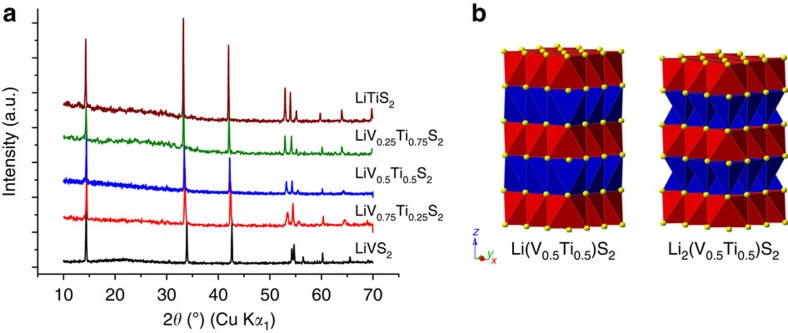
Structures of Li(V1-xTix)S2 and Li2(V0.5Ti0.5)S2.(a) Powder X-ray diffraction patterns of as-prepared Li(V1-xTix)S2. (b) Crystal structures of Li(V0.5Ti0.5)S2 and Li2(V0.5Ti0.5)S2. Red octahedra—MS6, blue polyhedra—LiSx and yellow spheres—sulfur.